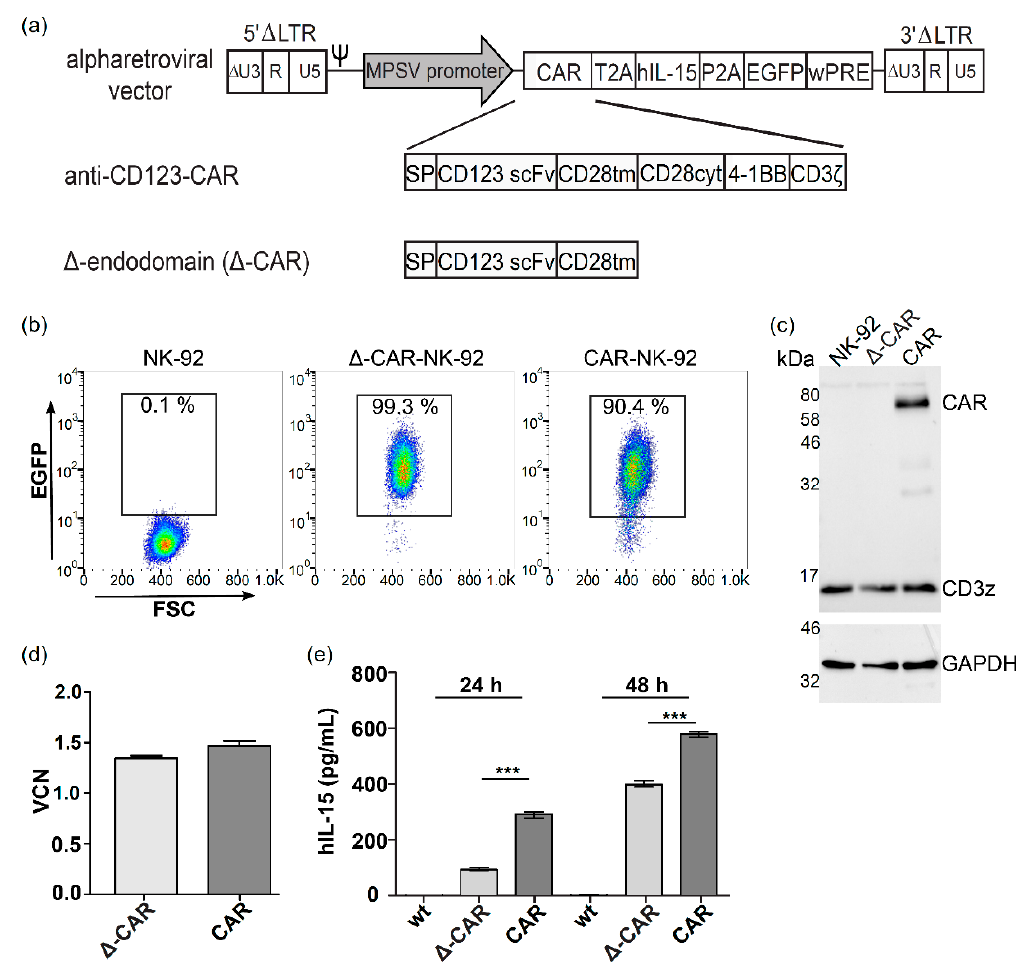
Figure 1. Alpharetroviral vectors were used to generate anti-CD123-CAR-NK-92 cells, which were also engineered to secrete hIL-15. ( a ) Schematic of alpharetroviral vectors. The myeloproliferative sarcoma virus (MPSV) promoter was used to express all constructs, including the full-length anti-CD123-CAR, the truncated CAR ( ∆ -CAR), human interleukin-15 (hIL-15), and enhanced green fluorescent protein (EGFP). SP, signal peptide derived from the GM-CSF receptor; CD28tm, the transmembrane domain of CD28; CD28cyt, the cytoplasmic domain of CD28; LTR, long-terminal repeat ( ∆ U3, R and U5); Ψ , packaging signal; wPRE, woodchuck hepatitis virus post-transcriptional regulatory element. ( b ) Flow cytometric analyses showing enrichment of anti-CD123-CAR-NK-92 cells and ∆ -CAR-NK-92 cells using the EGFP marker transgene to detect modified cells. Representative results from more than four experiments are shown. ( c ) The intact anti-CD123-CAR was detected via immunoblot experiments with an antibody directed against CD3 ζ , which also detects the endogenous CD3 ζ visualized as the marked band just below 17 kDa. An antibody to detect GAPDH was used as an additional control. Representative immunoblots from two to three experiments are shown. ( d ) Quantitative PCR showed similar vector copy numbers in CAR-NK-92 and ∆ -CAR-NK-92 cells. Shown are mean values with standard deviations from experiments accomplished as technical triplicates. ( e ) hIL-15 secretion from unmodified NK-92 cells (wt), ∆ -CAR-NK-92 cells or full- length CAR-NK-92 was quantified by ELISA. Experiments were accomplished twice in triplicate. Mean values with ranges are shown. Statistically significant differences are indicated by *** ( p ≤ 0.001).